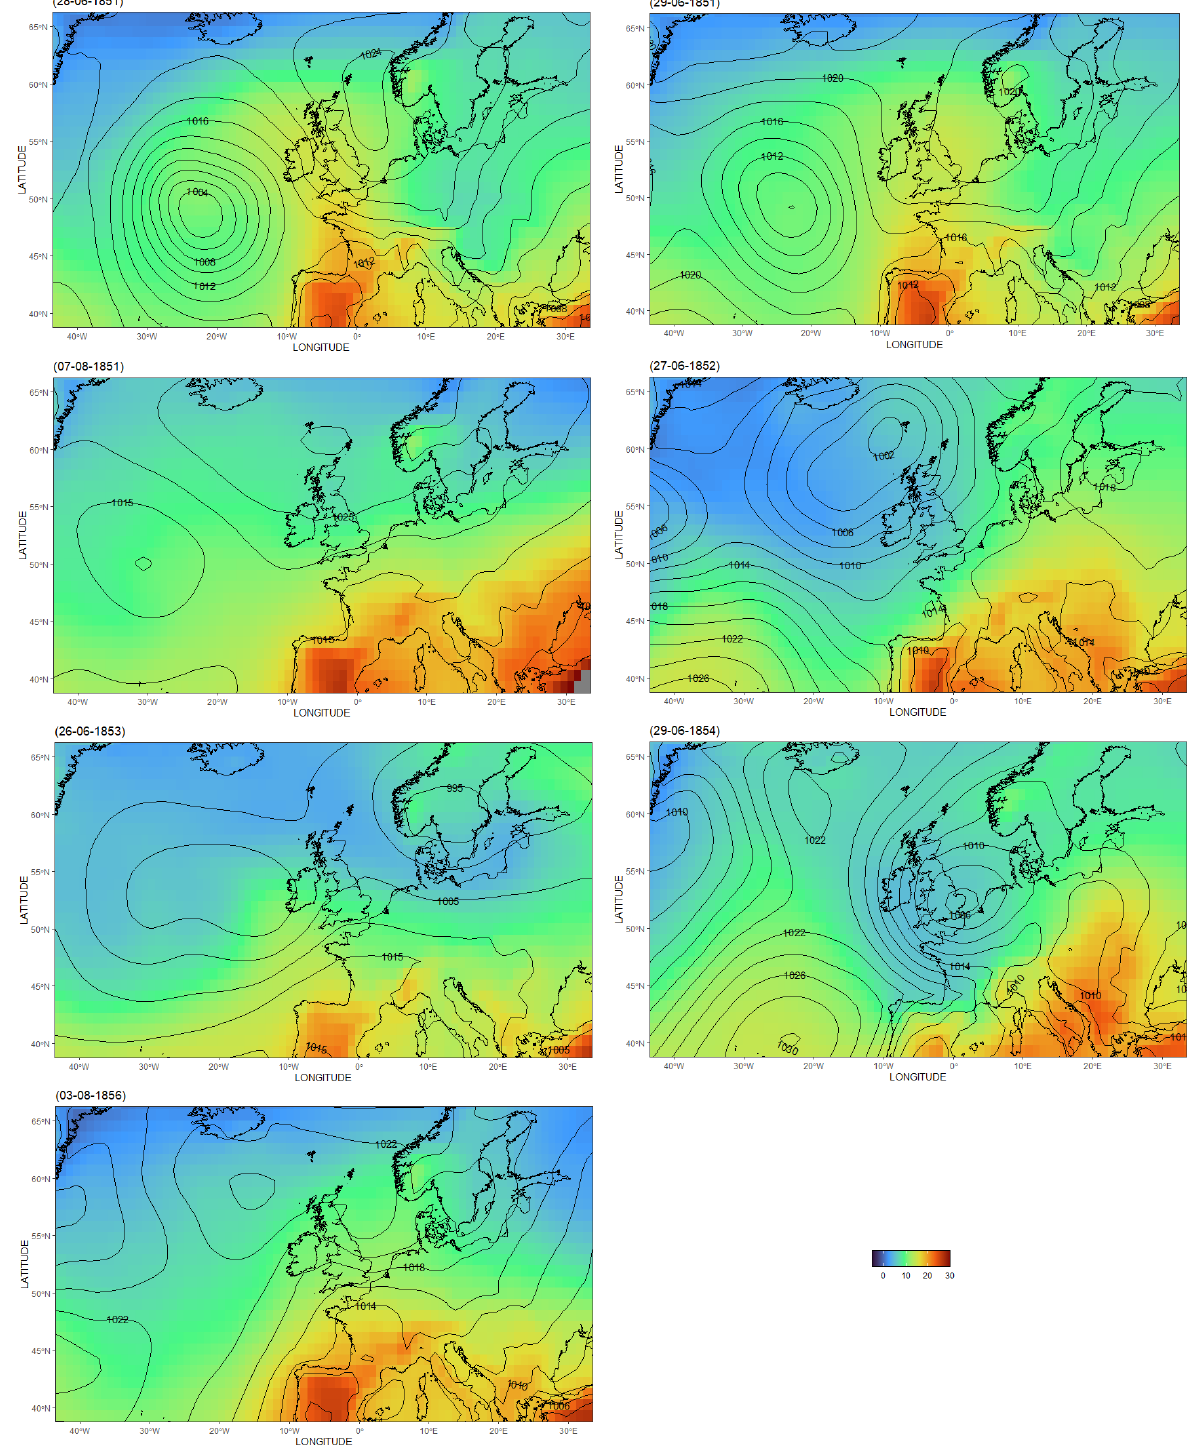
Figure 8. NOAA 20CRv3 MSLP and 850hPa temperatures on the dates of the possible heat records in the 1850s arising from the recent Mateus et al. (2020) data rescue and as documented in Table 2. The 20th Century Reanalysis V3 data provided by the NOAA/OAR/ESRL PSL, Boulder, Colorado, USA, from their web site at https://psl.noaa.gov/data/gridded/data.20thC_ReanV3.html (last access: 21 January 2022). The domain of latitude 35–70 ◦ N and longitude 45 ◦ W–30 ◦ E was chosen to provide a synoptic view, with Ireland centred to provide an overview of the surrounding regions. All maps correspond to 15:00UTC, which is the approximate expected time of daily maxima in Ireland (corresponding to ca.